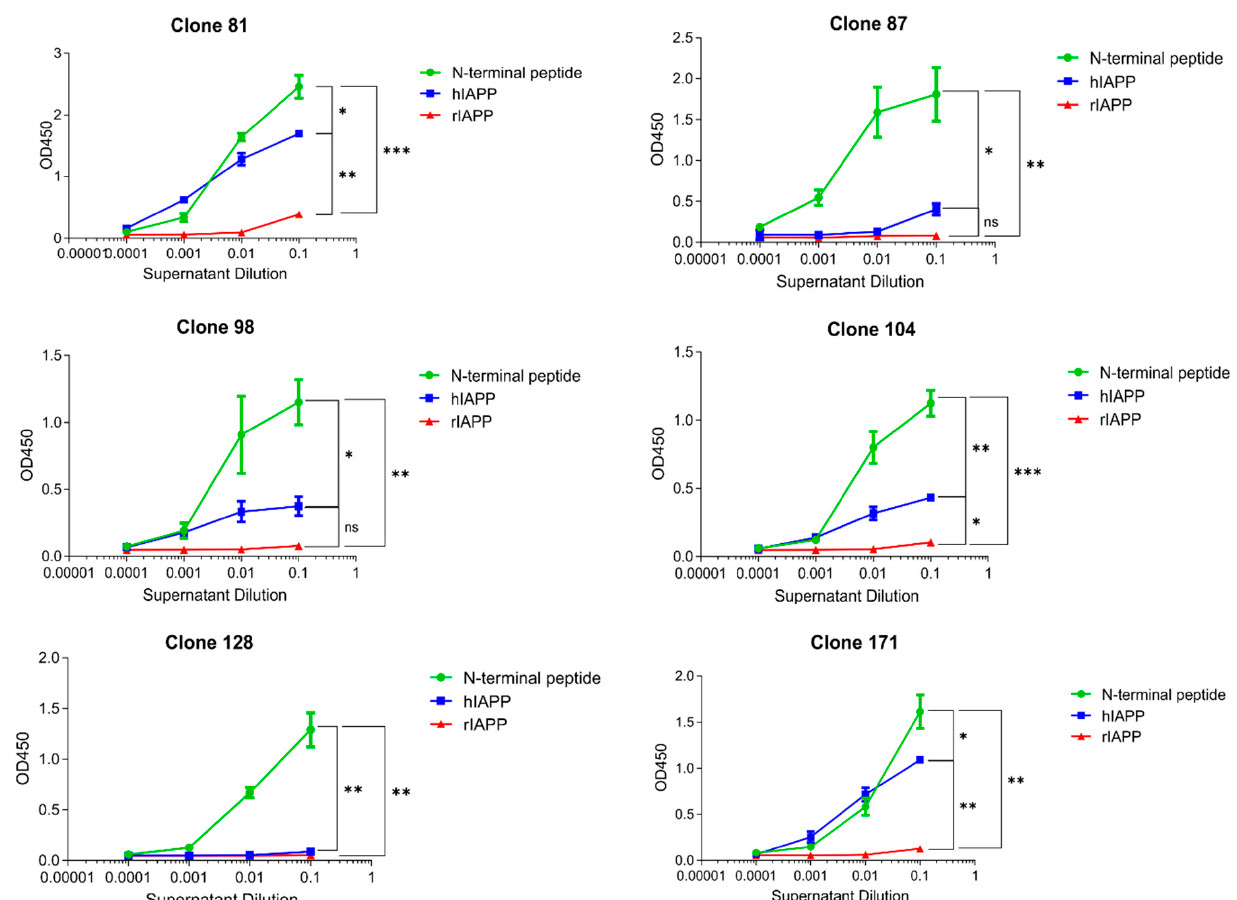
Figure 1. Binding specificity of different hybridoma clones. Different clones were tested in an ELISA assay with either RNase-Nterm(S-S) (green circle), hIAPP (blue square), or rIAPP (red triangle) coating. Data are presented as mean ± SEM. * p < 0.05, ** p < 0.01, *** p < 0.001.